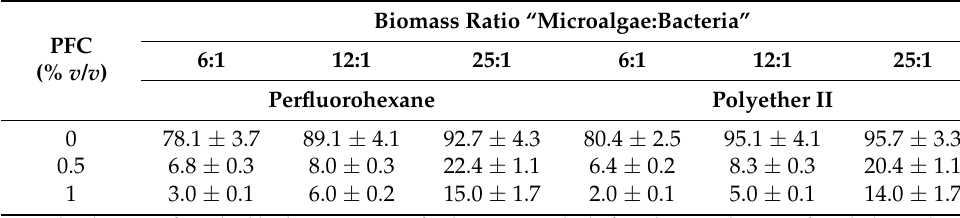
Table 3. Residual bioluminescence * (%) of photobacteria in media after 24 h of cultivation of a consortium of P. esterophilus , R. ruber bacteria and C. vulgaris microalgae in wastewater with 0.15 mM methyl parathion and different